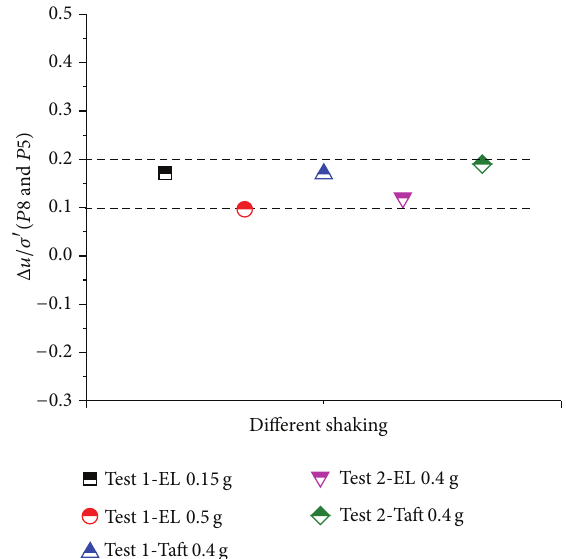
Figure 9: Excess pore pressure of P5 when pipe 1# starts to